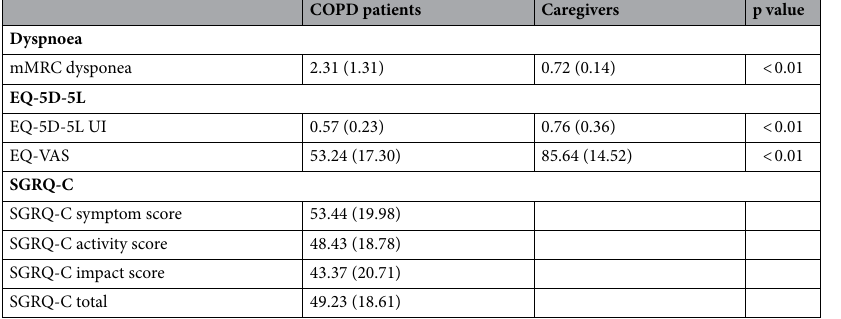
Table 4. Humanistic burden due to COPD on patients and their caregivers. All results displayed as mean (standard deviation) unless otherwise stated. EQ-5D-5L, European quality of life 5-Dimension 5-Level questionnaire; EQ-UI, EQ-5D-5L utility index; EQ-VAS, EQ-5D-5L vertical visual analogue scale; mMRC dyspnoea, Modified medical research council dyspnoea scale; SGRQ-C, Malaysian version of St. George’s Respiratory COPD specific